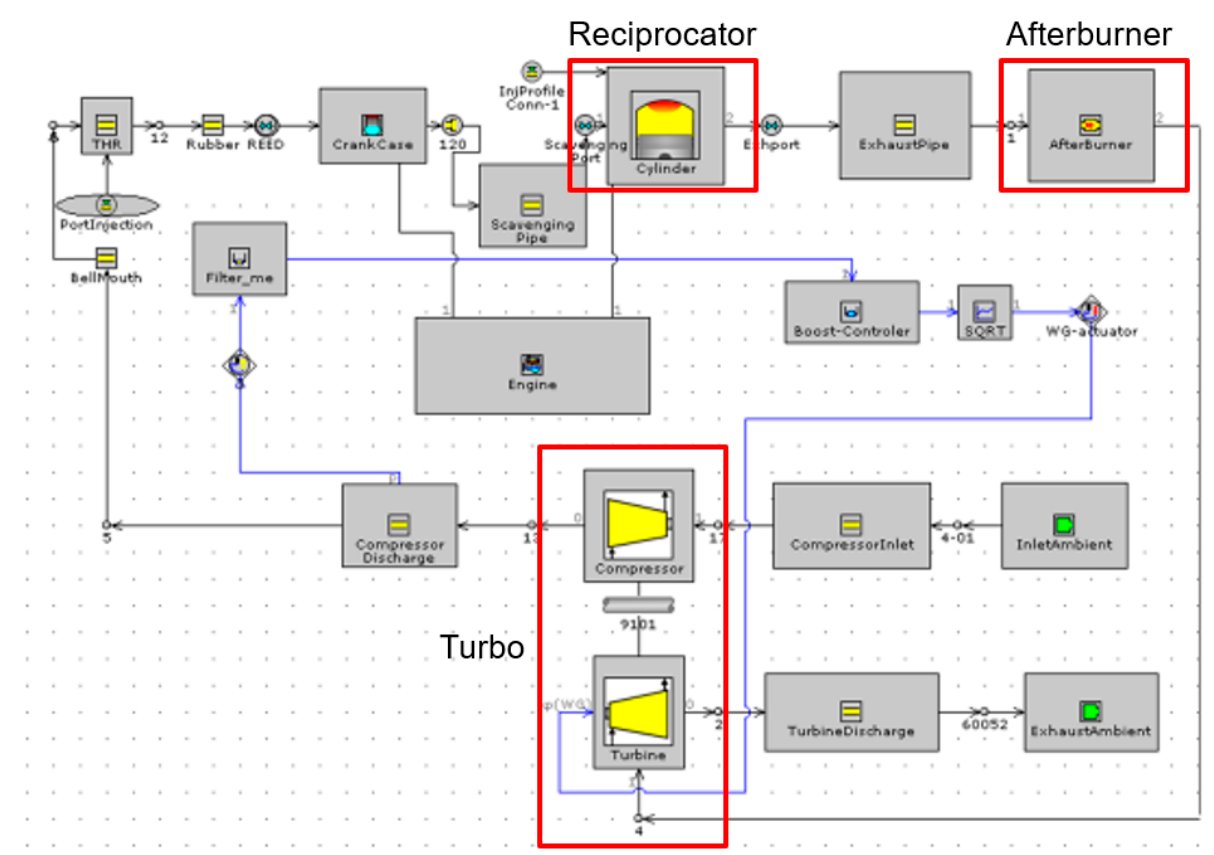
Figure 3. The 1D engine model generated using the GT-Suite software package including turbocharger and afterburner objects.